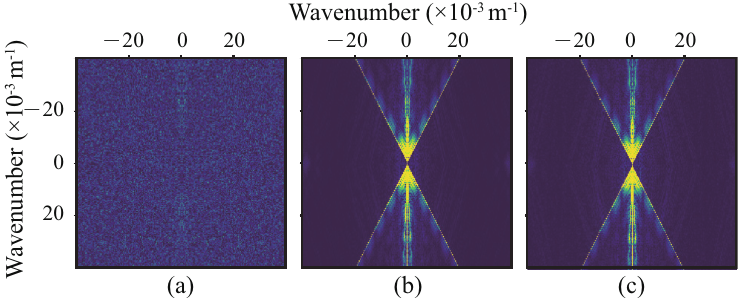
Figure 11. Wavenumber spectrum, ( a ) spectrum of Figure 10a, ( b ) spectrum of Figure 10c, ( c ) spectrum of Figure